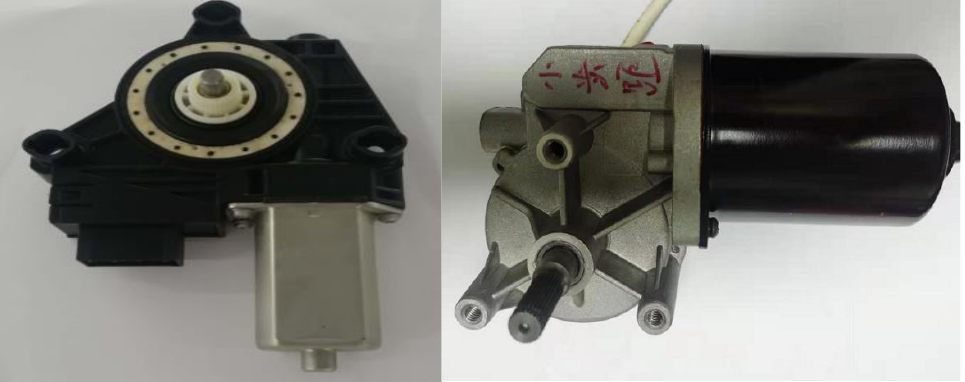
Figure 19. Gearbox samples.